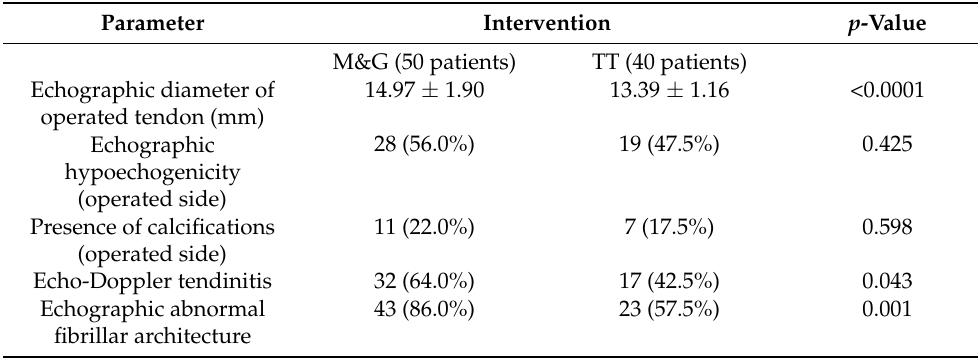
Table 3. Comparison of ultrasound outcomes between the M&G and T